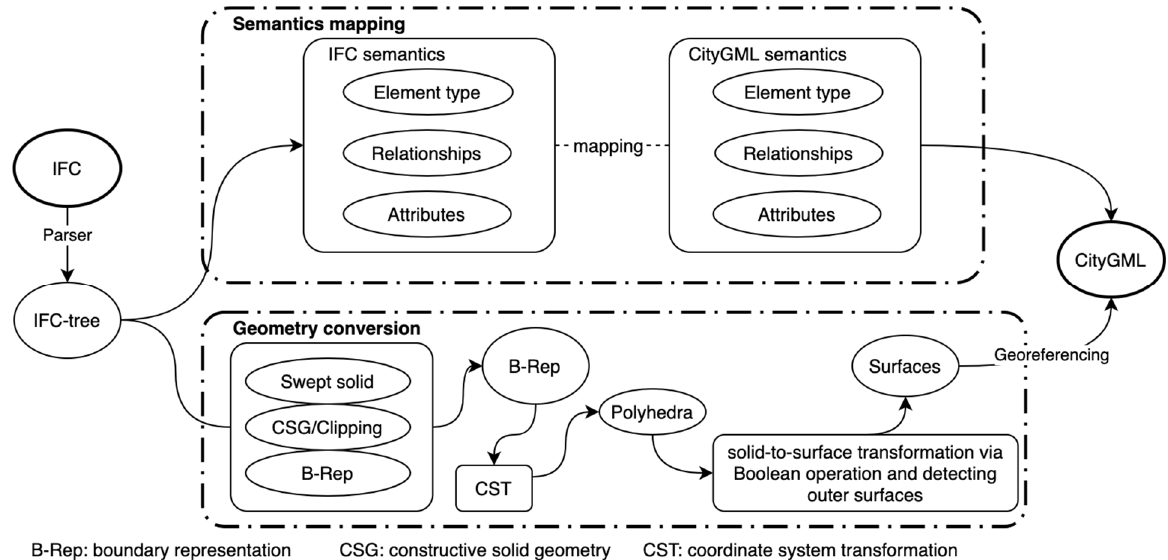
Figure 1. Tasks in conversion/simplification from Industry Foundation Classes (IFC) to City Geography Markup Language (CityGML).